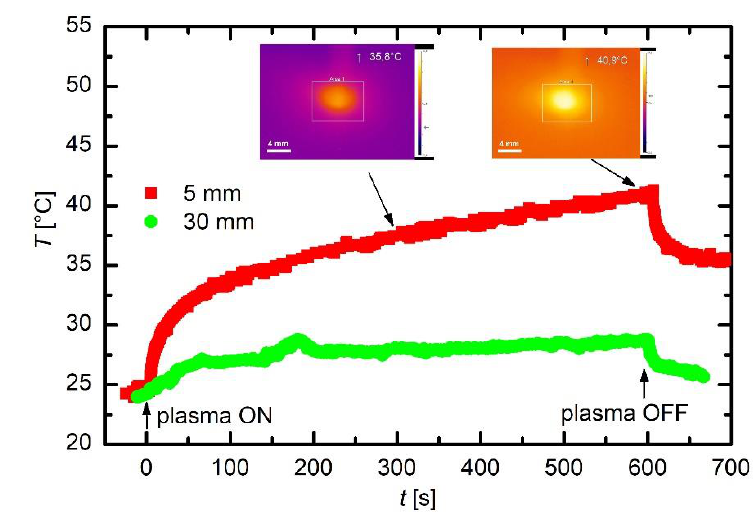
Figure 16. Evolution of sample temperatures as determined with the IR Pyrometer for the case when samples were placed 5 and 30 mm from the nozzle of the discharge tube.